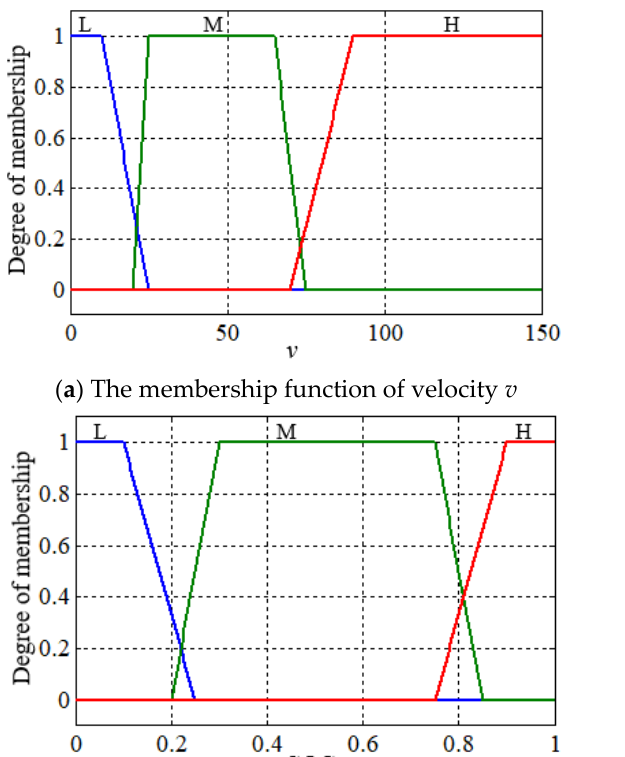
Table 2. Fuzzy rule table.